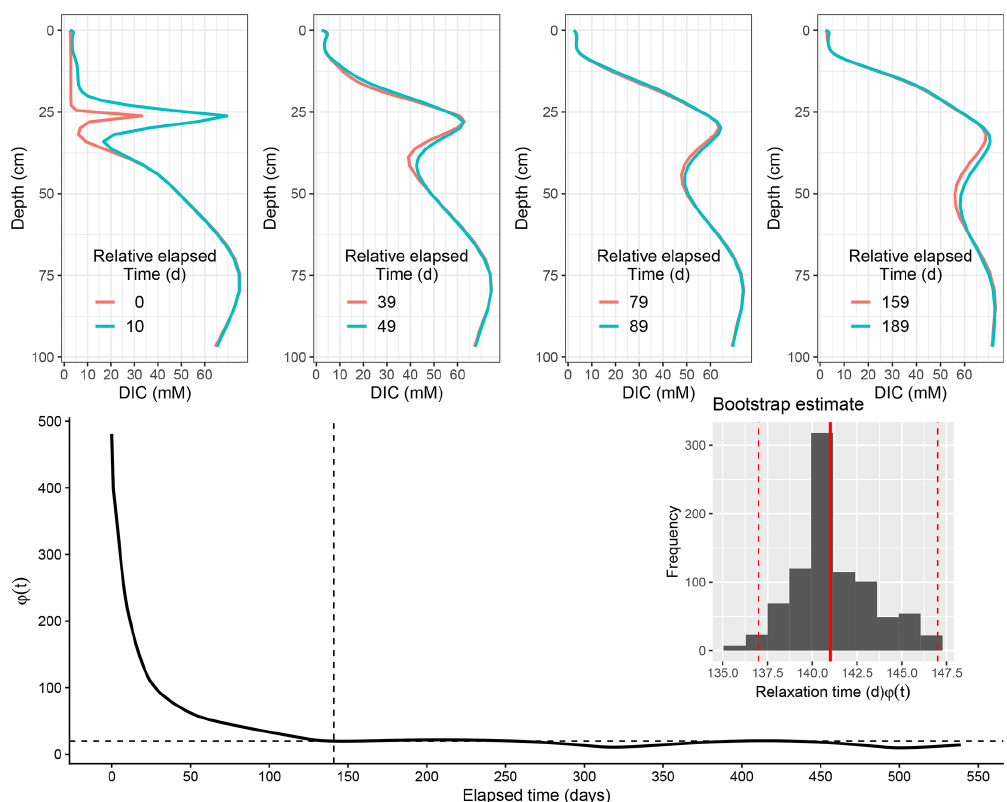
Figure 6. Scenario 1 (EM1): model evolution for DIC following deposition. Relative deviation of successive profile with time shown below. Dashed vertical line signifies cutoff point by the median (dashed horizontal line). Inset: histogram of bootstrap estimate of DIC relaxation timescale for EM1 with 95% confidence